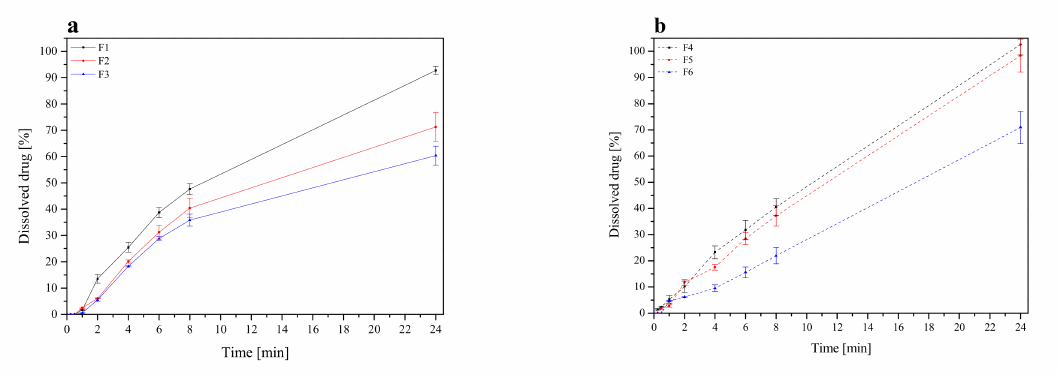
Figure 6. Resveratrol dissolution profiles from tablets F1–F3 ( a ) and F4–F6 ( b